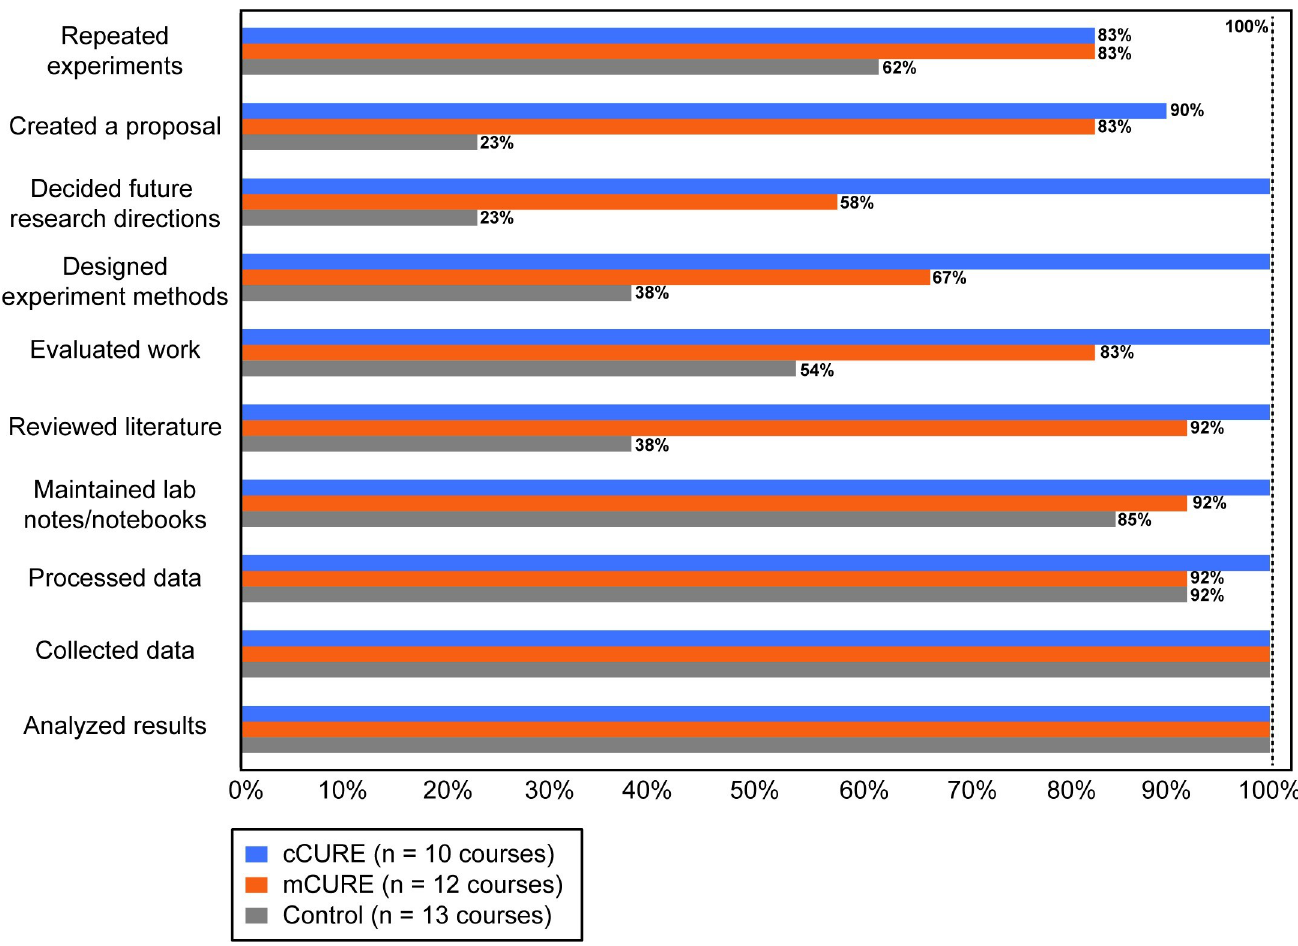
Fig 3. Faculty descriptions of their course elements are consistent with CURE and control classes. The ten elements of a CURE are listed with the percentage of faculty that indicated each element was included in their course. Due to the small sample size, statistical analysis was not done. Descriptively, most cCURE faculty included all 10 elements, most mCURE faculty included 8 of the 10 elements, and most control faculty included 4 of the 10 elements.